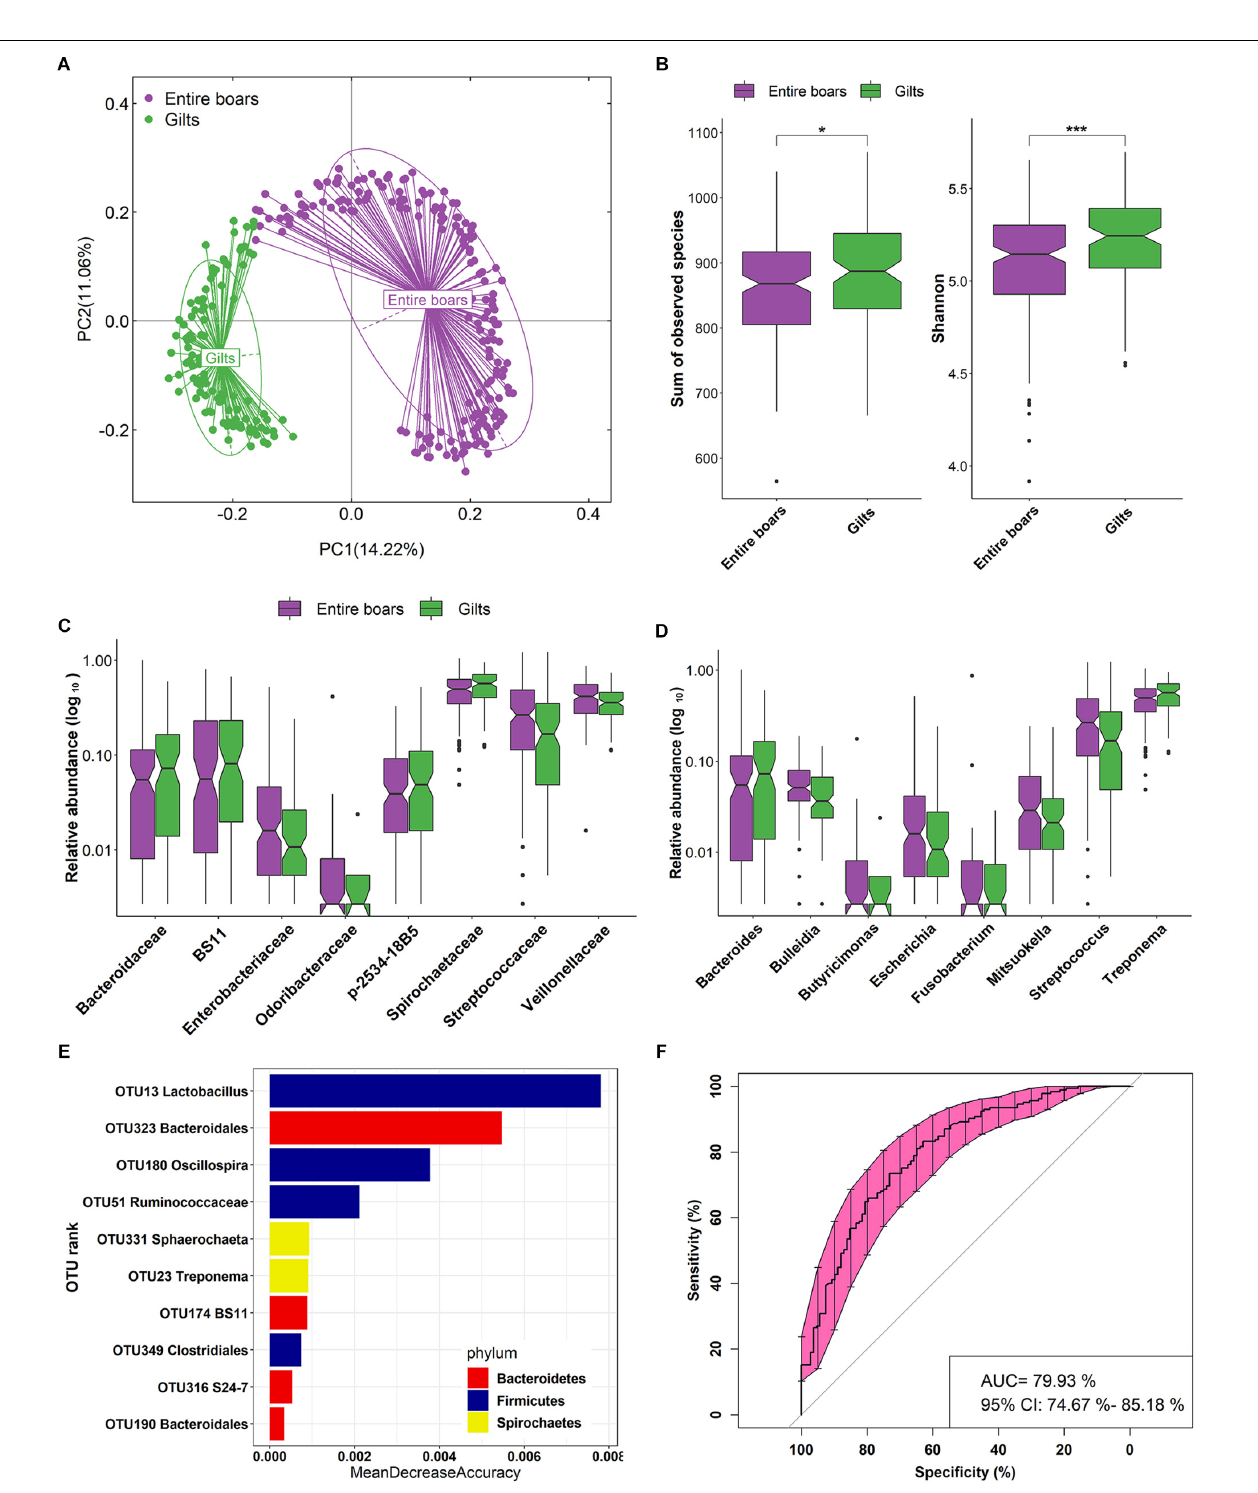
FIGURE 1 | Distinct gut microbial compositions between entire boars and gilts in the Duroc pig cohort. (A) Distinct gut microbial compositions identified by Principle coordinates analysis which was performed based on Bray–Curtis distance. (B) Comparison of α -diversity of the fecal microbiota (observed species and Shannon index) between gilts and entire boars. Violin plots show that gilts had the higher richness and diversity of fecal microbiota than entire boars. ∗ P < 0.05, ∗∗ P < 0.01, and ∗∗∗ P < 0.001. (C,D) The sex-biased bacterial taxa at the family and genus level. (E) The top 10 biomarkers of OTUs that could discriminate the male and female samples by Random Forest model. Biomarker OTUs were ranked in descending order of importance to the accuracy of the model. (F) Receiver operating curve (ROC) for the Duroc population. The AUC was 79.93% with the 95% CI of 74.67–85.18%.